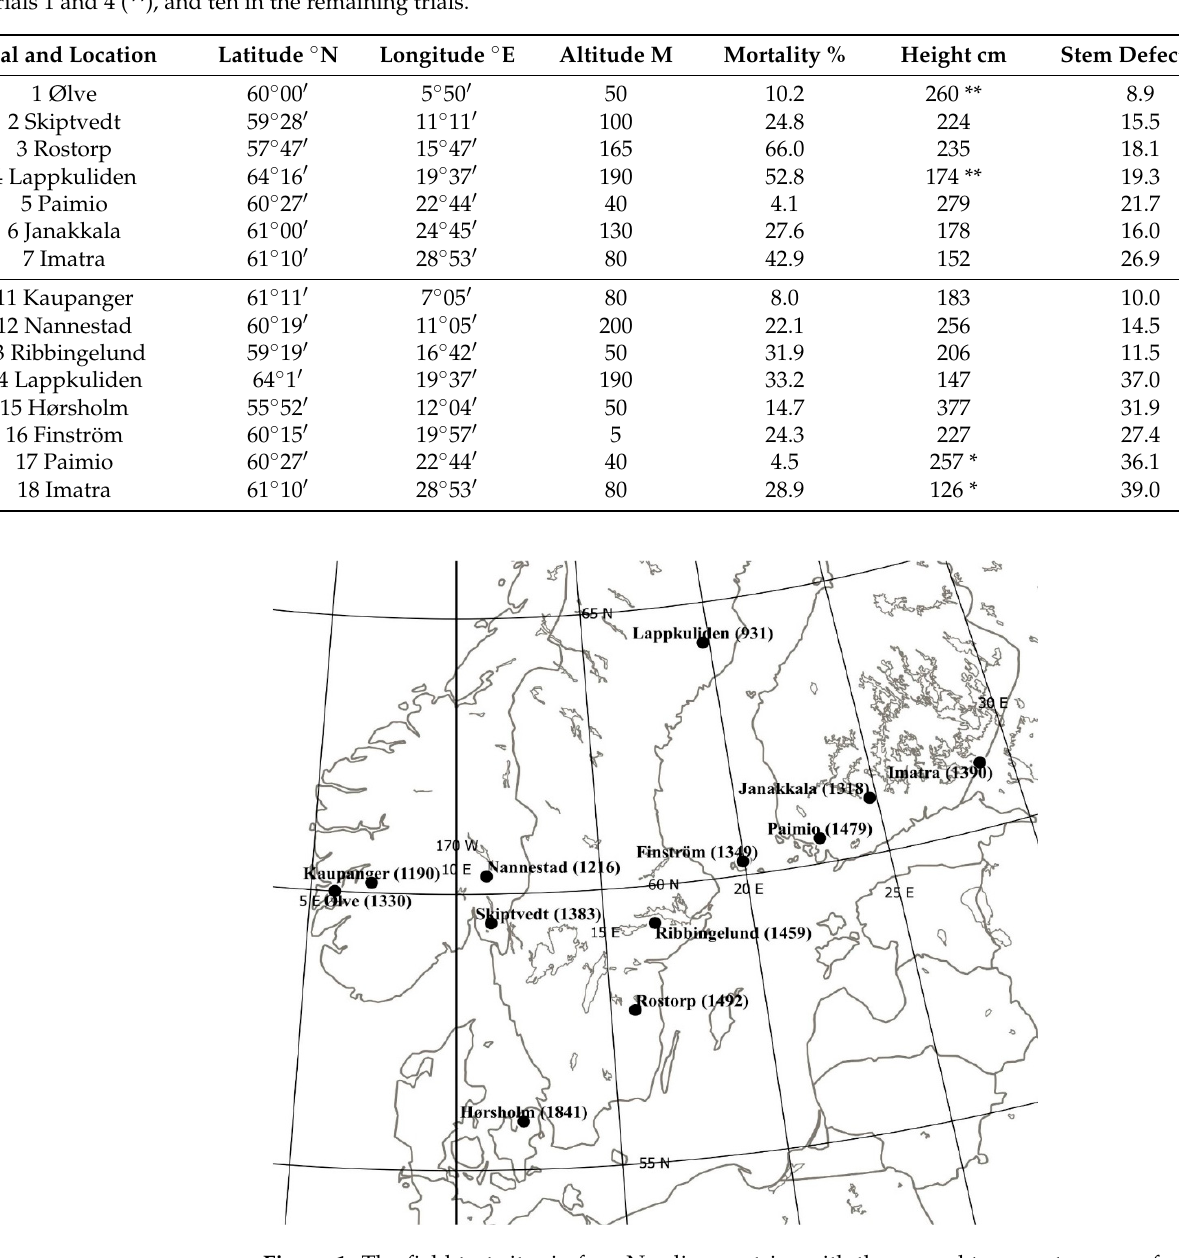
Table 1. Locations of field trials with average survival (%), tree height, and proportion of trees with stem defects. Trials 1, 2, 11, and 12 are in Norway; trials 3, 4, 13, and 14 in Sweden; trials 5, 6, 7, 16, 17, and 18 in Finland; and trial 15 is in Denmark. Trials 1 to 7 comprise provenances and families, while trials 11 to 18 comprise clones propagated from 20 of the families. The average values are obtained from measurements nine growing seasons after planting in trials 17 and 18 (*), eleven in trials 1 and 4 (**), and ten in the remaining trials.